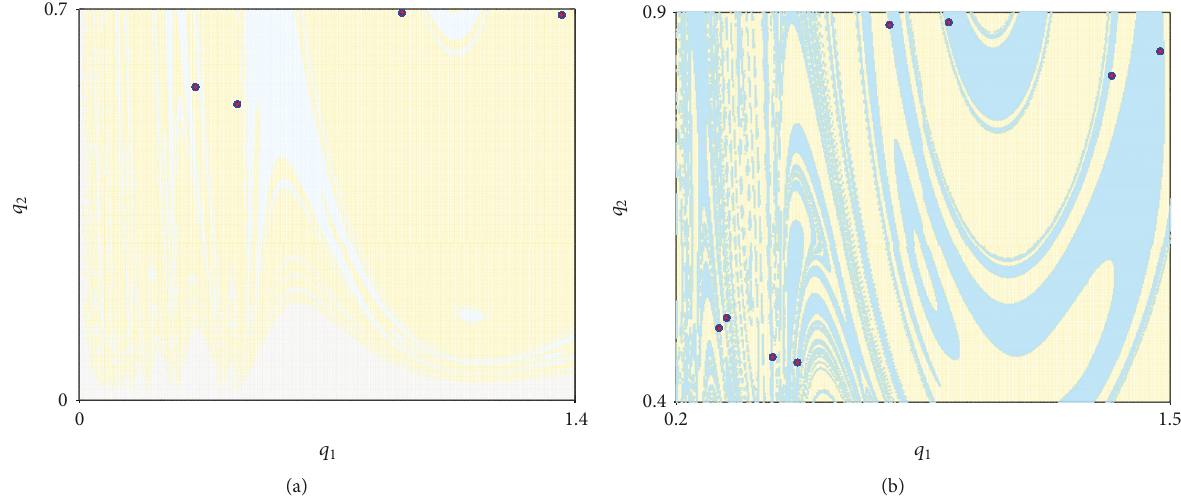
Figure 5: (a) Plane section of basin of attraction at 𝑘 1 = 9, 𝑘 2 = 5 , 𝑘 3 = 7.5 , 𝑐 1 = 0.19 , 𝑐 2 = 0.18 , 𝑐 3 = 0.17 , and 𝑞 3 = 5.39 . (b) Plane section of basin of attraction at 𝑘 1 = 8.75 , 𝑘 2 = 7 , 𝑘 3 = 8.1 , 𝑐 1 = 0.19 , 𝑐 2 = 0.18 , 𝑐 3 = 0.17 , and 𝑞 3 = 5.81 .